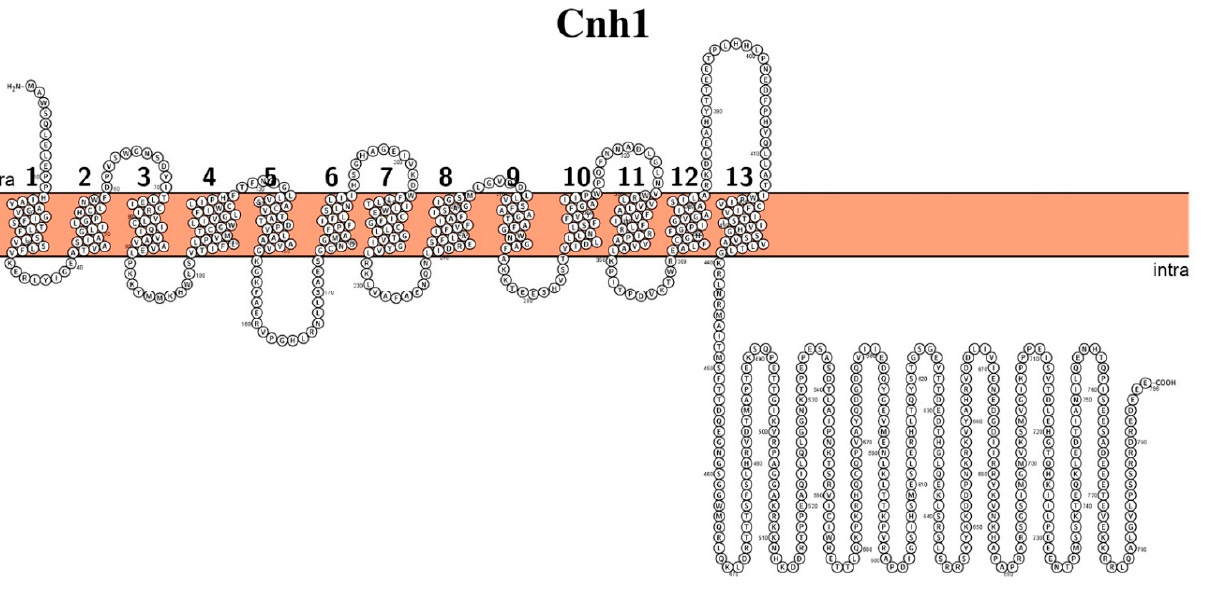
Figure 2. Schematic representation of the proposed secondary structure and topology of Cnh1.